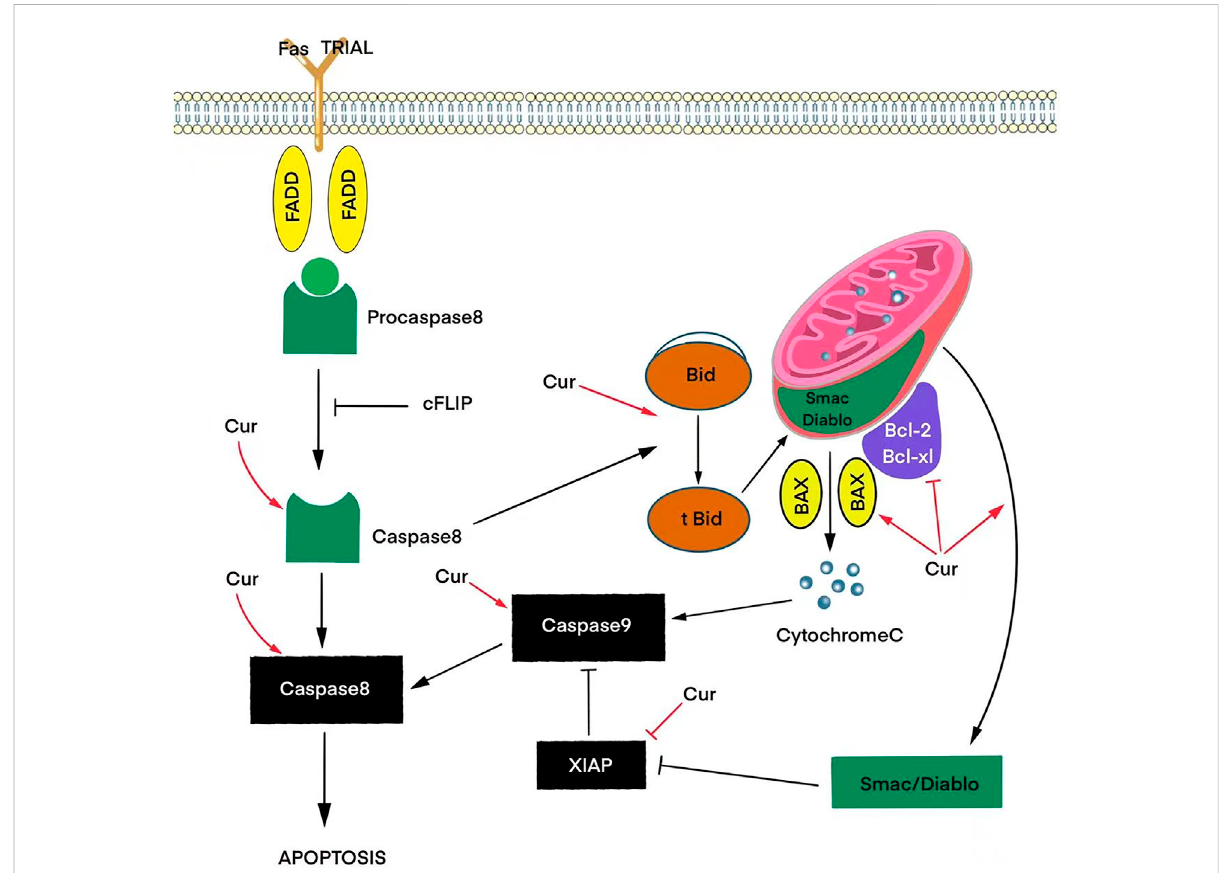
FIGURE 1 Effects of curcumin (Cur) on signaling pathways that trigger apoptosis via activation of pro-apoptotic proteins (BAX) and inhibition of anti- apoptotic proteins (Bcl-2, Bcl-xL, XIAP) to release the caspase and cytochrome C cascade.